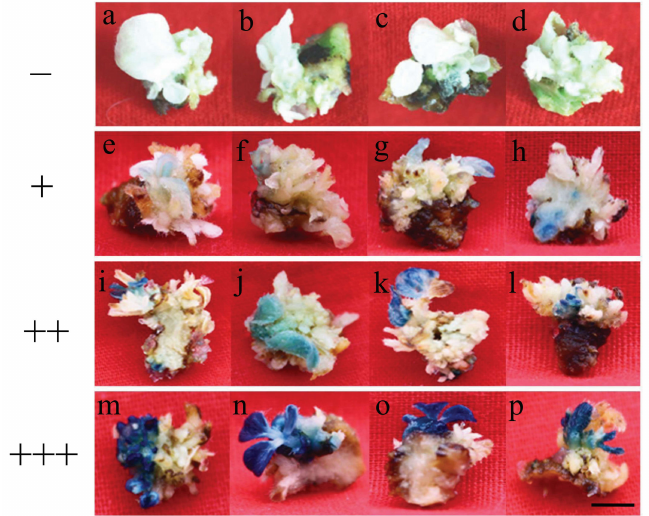
Figure 1. The fourclasses of multiple shoots for transgene (GUS) staining. ( a – d )“ − “Representation of negative; ( e – h )“+” representation of low dyeing; ( i – l )“++” representation of medium dyeing; ( m – p )“+++” representation of high dyeing. Scale bar, 1